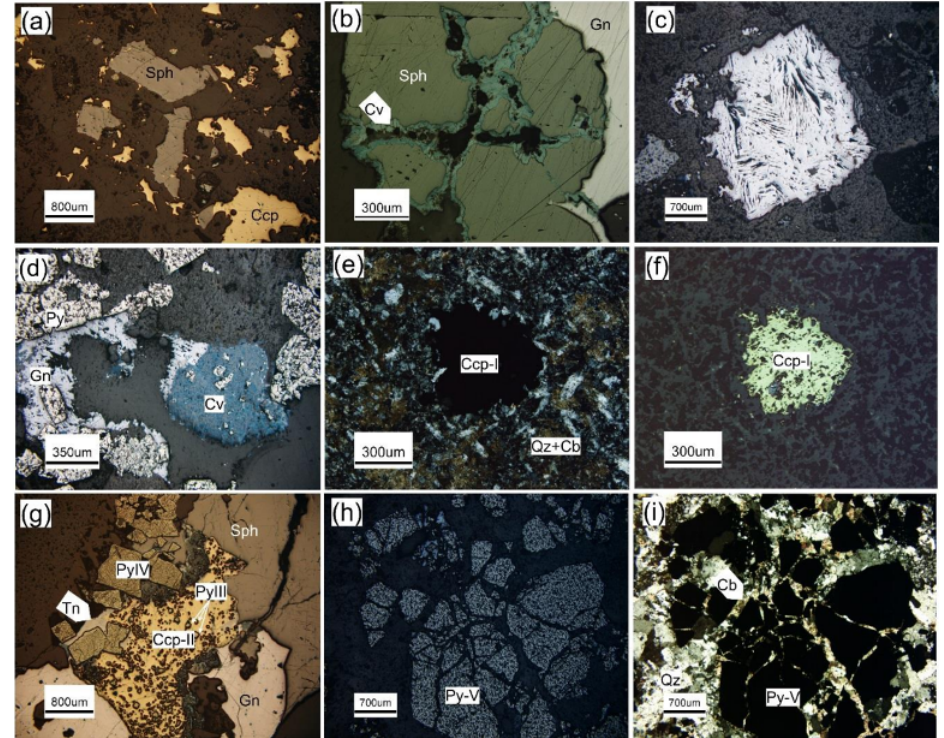
Figure 12. Photomicrographs of the sulfide minerals from Shah-Ali-Beiglou deposit showing the textural relations among the minerals (images are taken under reflected plane-polarized light, except e and I that are taken under transmitted cross-polarized light). ( a ) Chalcopyrite (Ccp) crystals are replaced by sphalerite (Sph); ( b ) Sphalerite is substituted by covellite (Cv) along with borders and fissure planes in the breccia-I; ( c ) Single grain of galena in silica cement containing undulation and displacement triangular pits in the Breccia-III; ( d ) Replacement of galena (Gn) by covellite in breccia-I; ( e , f ) Rounded grain of chalcopyrite in breccia-I; ( g ) Pyrite-II (Py-II) substituted by chalcopyrite and both of them are substituted by galena and sphalerite; ( h , i ) Occurrences of coarse-grained pyrite-IV (Py-IV) at contact between quartz and carbonate